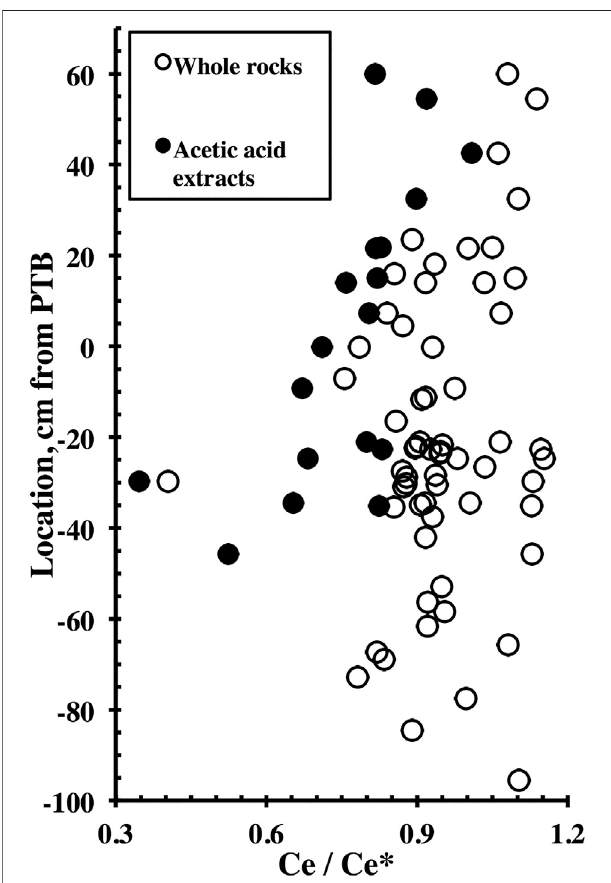
FIGURE 10 | Stratigraphic pattern of Ce/Ce* calculated by the method of Bolhar et al. (2004), with data from whole rocks and acetic acid extracts. Acetic acidextracts systematically have lower Ce/Ce* than the corresponding whole